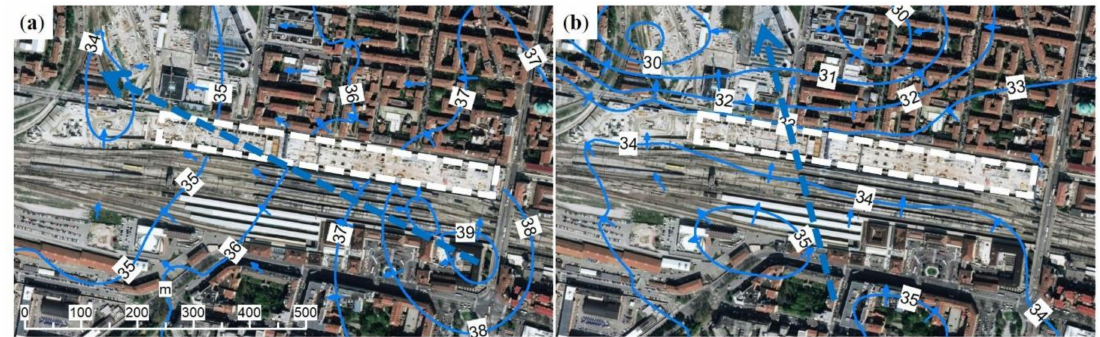
Figure 2. Representation of piezometric surface (m a.s.l.) for ( a ) shallow and ( b ) intermediate aquifer, dashed white rectangle represents excavation hosting station structure.